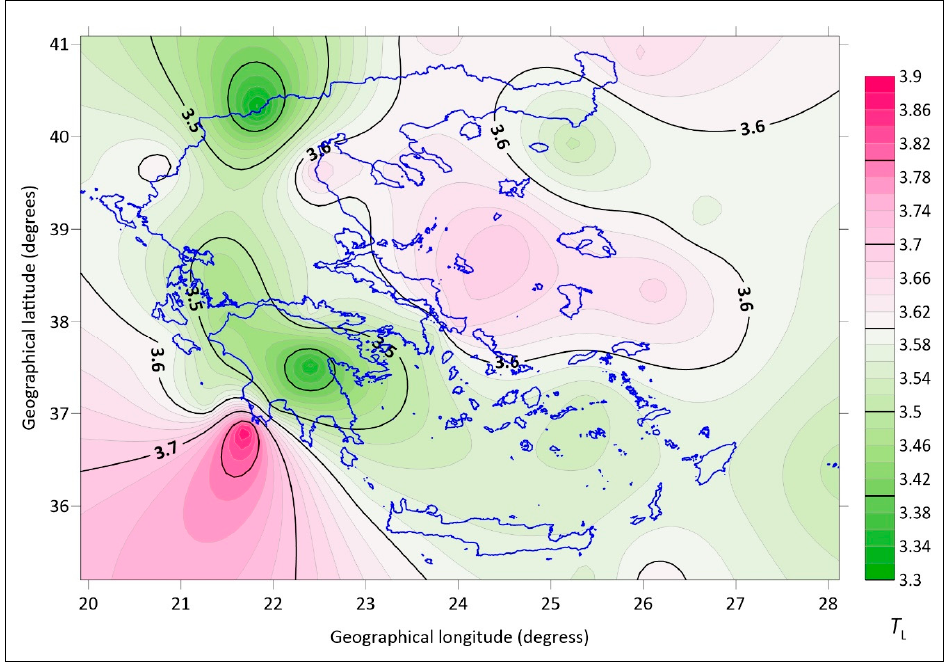
Figure 12. Map of annual mean T L values over Greece for all (upper graph) and clear-sky (lower graph) conditions during TATY.